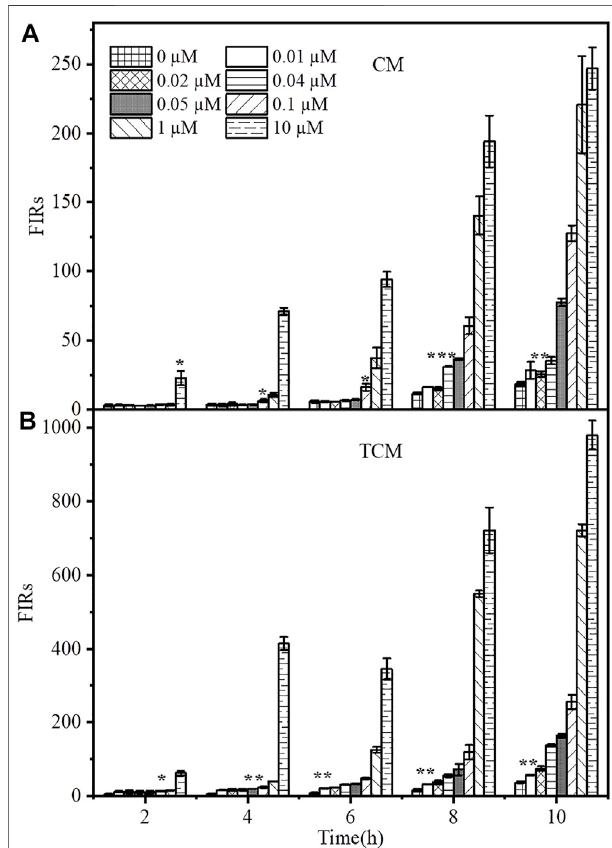
FIGURE 3 | Time-dependent response of Cd 2+ biosensors without (A) andwith (B) negativefeedback.TheCMandTCMbiosensorcellsweregrown in medium containing 0, 0.00001, 0.0001, 0.001, 0.01, 0.02, 0.04, 0.05, 0.1, 1, or 10 μ M Cd 2+ . The error bars indicate the standard deviation of triplicate experiments. * p < 0.05; ** p < 0.01; *** p <